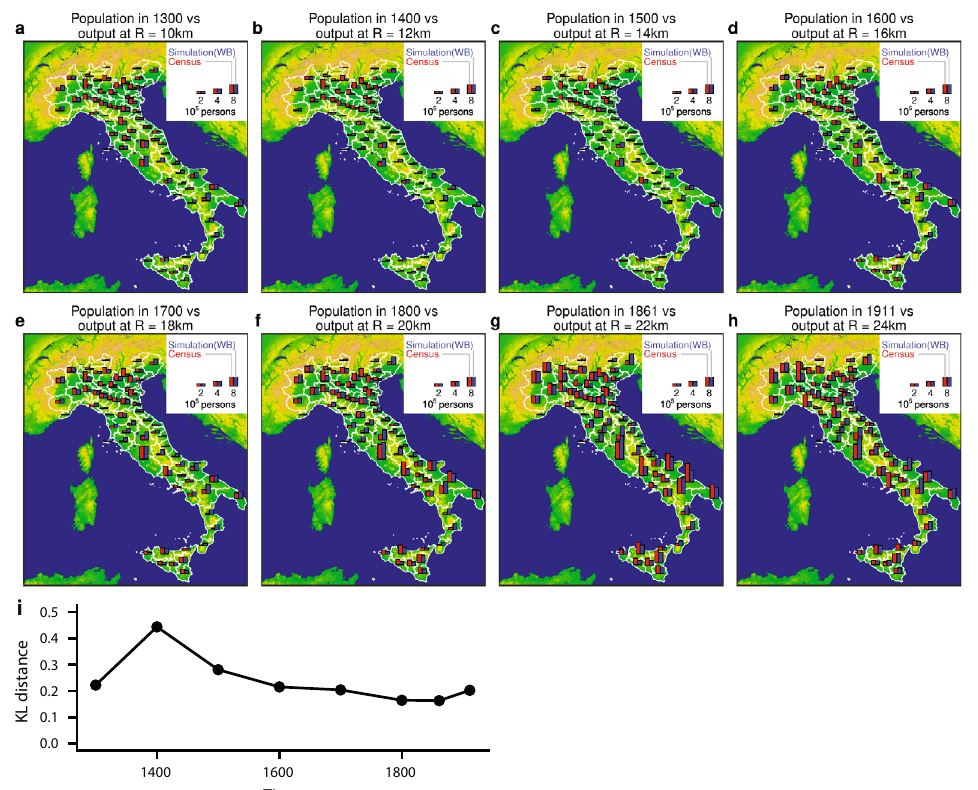
Figure 6. Comparison between the population distribution during the period 1300–1911 and the simulation output from intermediate levels of R . ( a–g ) As shown in Fig. 5d, the least-cost distance and characteristic transport distance R were varied during the simulation. The intermediate states of the model up to R = 22 km were compared with the estimated population distribution from city population data during the period 1300–1861 47 (see Methods for the details of the estimates). The population distributions from both the simulation output and the estimated data are aggregated by Provincia using the 1911 regions, as digital shape data is available at this time point. Red bars indicate the estimated populations and blue bars are the simulation output from the Water Bodies scenario. ( h ) Population distribution at 1911 for Italy (red) and the LTP simulation (blue) at R = 24 km when aggregated at Provincia level in 1911. ( i ) Quantitative comparison using the KL distance from the model outputs at intermediate values of R to empirical data shown in ( a–h